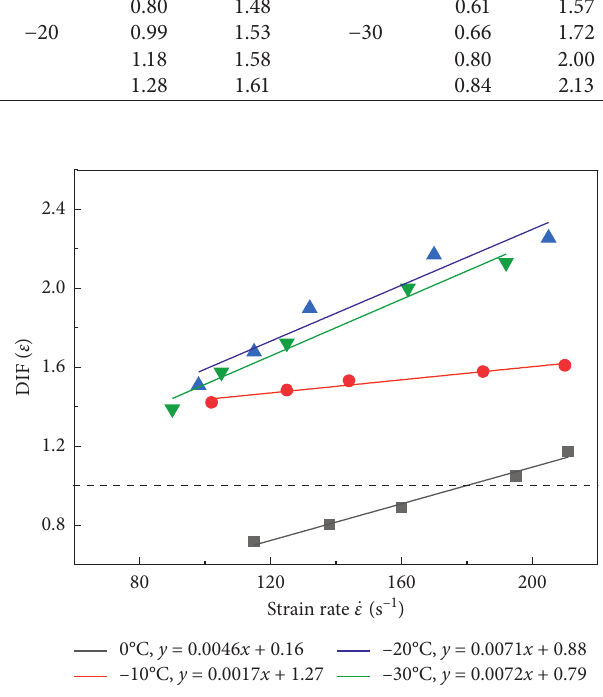
Figure 6: Relationship between DEIF and strain